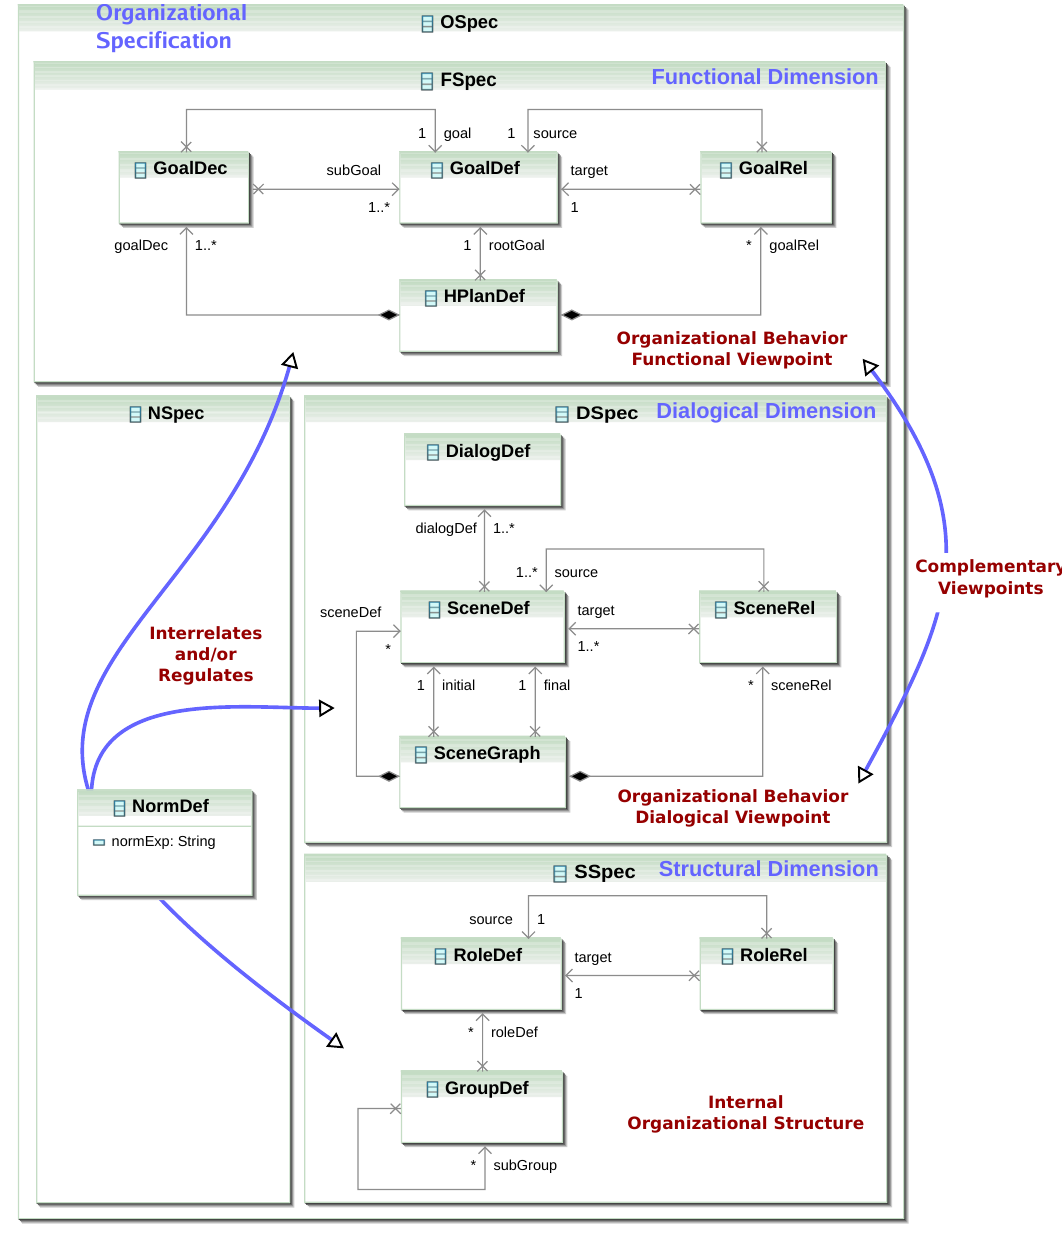
Figure 5. Abstract organizational